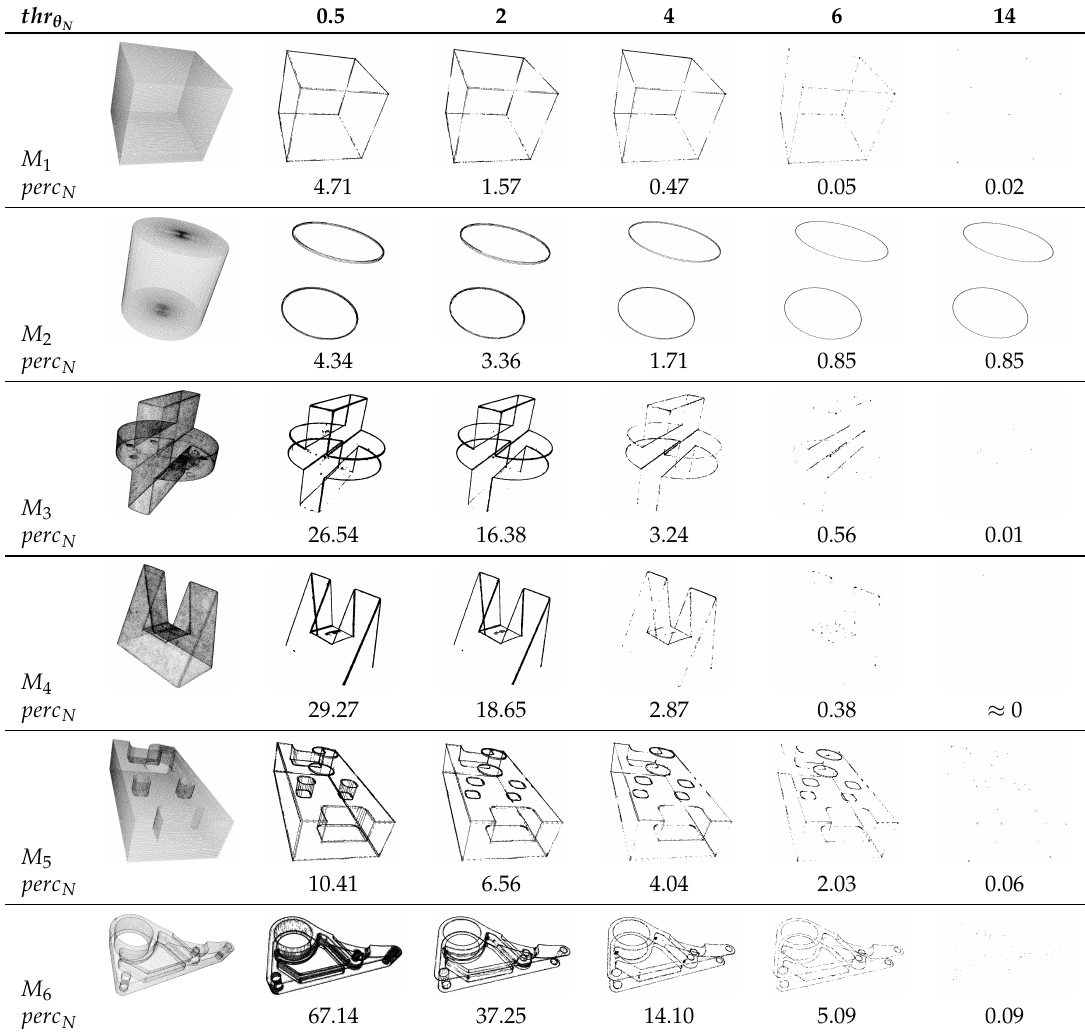
and perc N for all testing point N